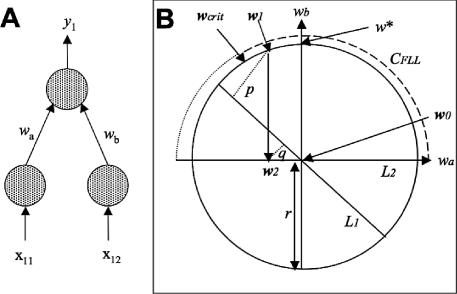
Geometry of Free-Lunch Learning(A) Given a network with two input units and one output unit, its connection weights wa and wb define a weight vector w = (wa,wb). The network learns two subsets A
1 and A
2. In this example, each subset is a single association, where A
1 (for example) is the mapping from input vector x
1 = (x
11,x
12) to desired output value d
1, and learning A
1 consists of adjusting w until the network output y
1 = w · x
1 equals d
1.(B) Each association A
1 and A
2 defines a constraint line L
1 and L
2, respectively. The intersection of L
1 and L
1 defines a point w
0 which satisfies both constraints, so that zero performance error on A = A
1 ∪ A
2 is obtained if w = w
0. After partial forgetting, the weight vector is a randomly chosen point w
1 on the circle C of radius r, and the performance error on A
1 is given by the squared distance p
2. After relearning A
2, the weight vector w
2 lies in L
2, and performance error on A
1 is the squared distance q
2. FLL occurs if performance error on A
1 is decreased by relearning A
2, or equivalently if p
2 > q
2. Relearning A
2 has three possible effects, depending on the position of w
1 on C: 1) if w
1 is under the larger (dashed) arc CFLL (as shown here), then p
2 > q
2; therefore, FLL is observed, 2) if w
1 is under the smaller (dotted) arc, then p
2 < q
2; therefore, negative FLL is observed, and 3) if w
1 is at the critical point w
crit, then p
2 = q
2; therefore, no FLL is observed. Given that w
1 is a randomly chosen point on the circle C, the probability of FLL is equal to the proportion of the upper semicircle under the (dashed) arc CFLL. Symmetry implies the above analysis also applies to the lower half of C. In terms of evolution, a network “born” with w = w
* has zero error on both A
1 and A
2 after learning only A
2 (see text).